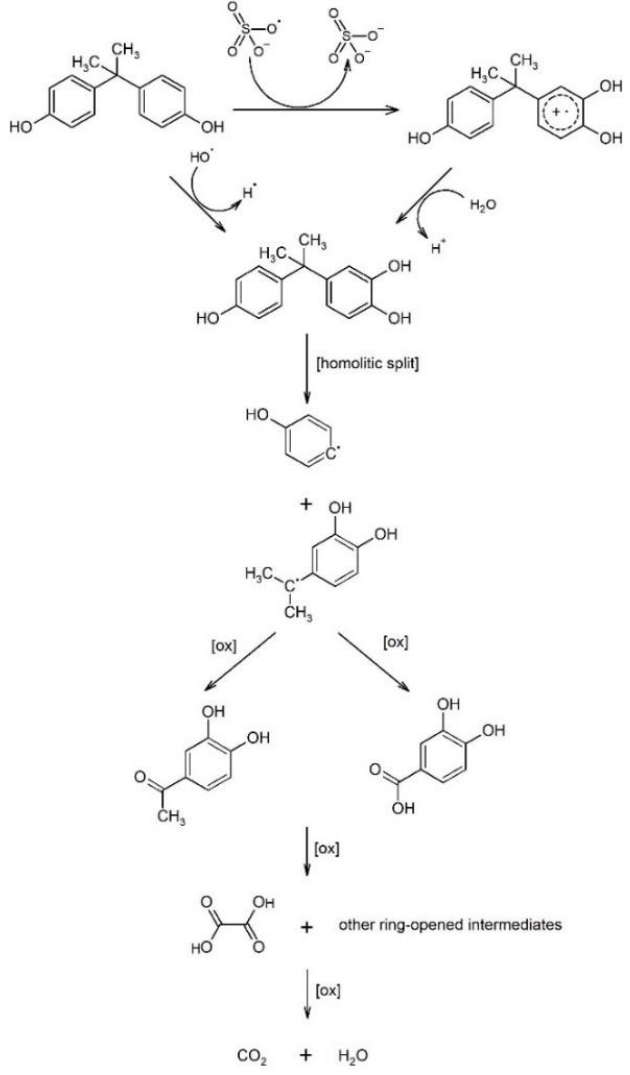
Figure 15. Example of degradation of a pollutant (bisphenol A) on the surface of a persulfate activated biochar. The reaction scheme has been re-elaborated with permission from Reference [138].